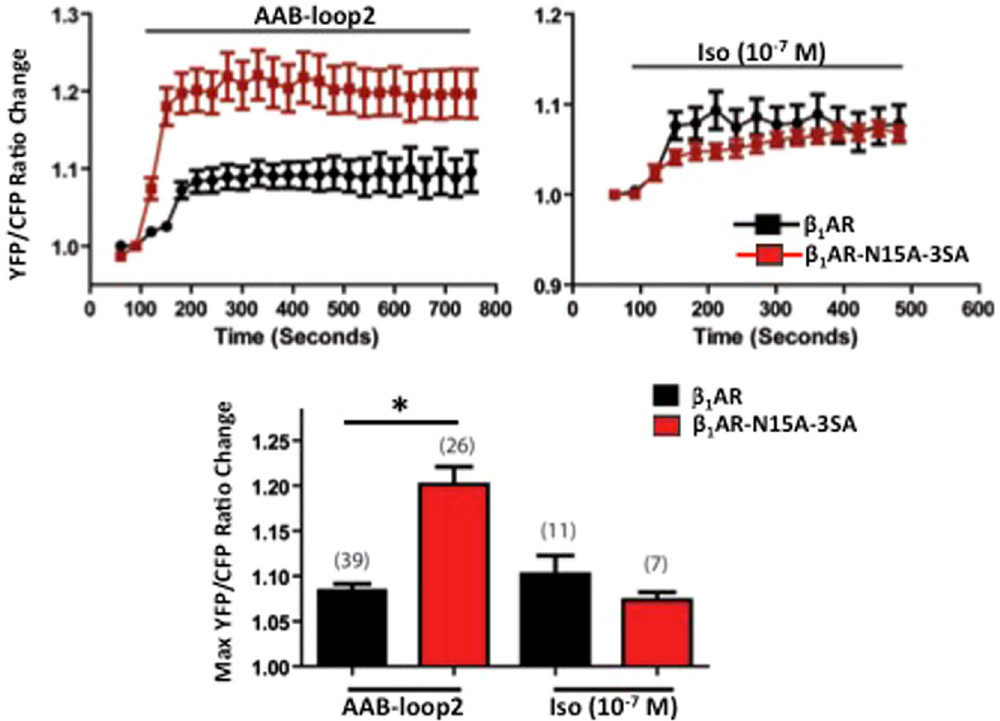
Figure 7. β 1 AR O-glycosylation influences responses to agonistic autoantibodies. Neonatal rat cardiomyocytes that heterologously overexpress PM-AKAR3 (the plasma membrane-localized PKA activity FRET biosensor) plus similar amounts of either S 49 -WT- β 1 AR or glycosylation defective S 49 - β 1 AR-N15A-3SA were stimulated with β 1 AR agonistic autoantibodies (AAB-loop2) or isoproterenol (10 − 7 M) and FRET was measured at 30 sec intervals. Note: The S 49 -WT- β 1 AR and S 49 - β 1 AR-N15A-3SA constructs used in these experiments are identical * p < 0.01 by one-way ANOVA followed by Tukey’s